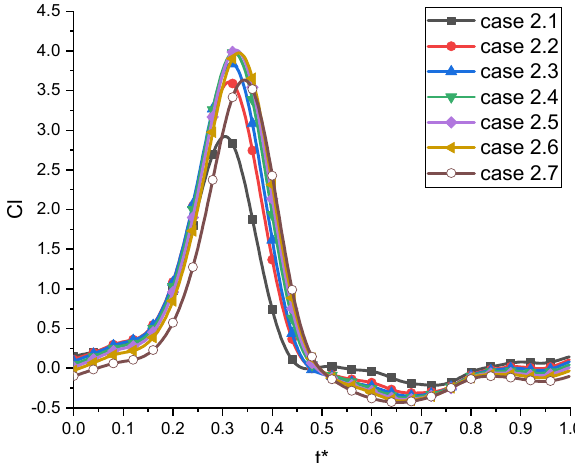
Figure 13. Instantaneous lift of cases with different dihedral. The spanwise distribution of pressure variation at section x = − 0.25 c and vorticity